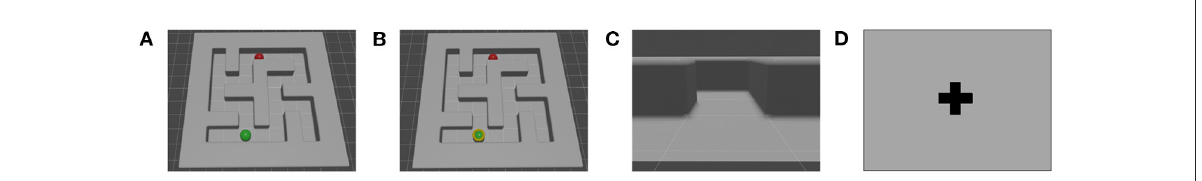
FIGURE2 Spatial decision task. (A) Picture 1. In this picture, green ball is the starting point and red ball is the ending point. Subjects need to infer the shortest path from the starting point to the ending point. (B) Picture 2. Picture 2 adds a choice point (yellow circle) on the intersection of the shortest path based on Picture 1. At this point, subjects need to judge which direction to take is the shortest path. (C) Picture 3. Picture 3 featured a first-person viewpoint of the choice point. Subjects should operate in this picture (W: go forward, A: go left, D: go right, S: all directions have the same path length). (D) Interstimulus interval (ISI), during which the subjects were allowed to rest.